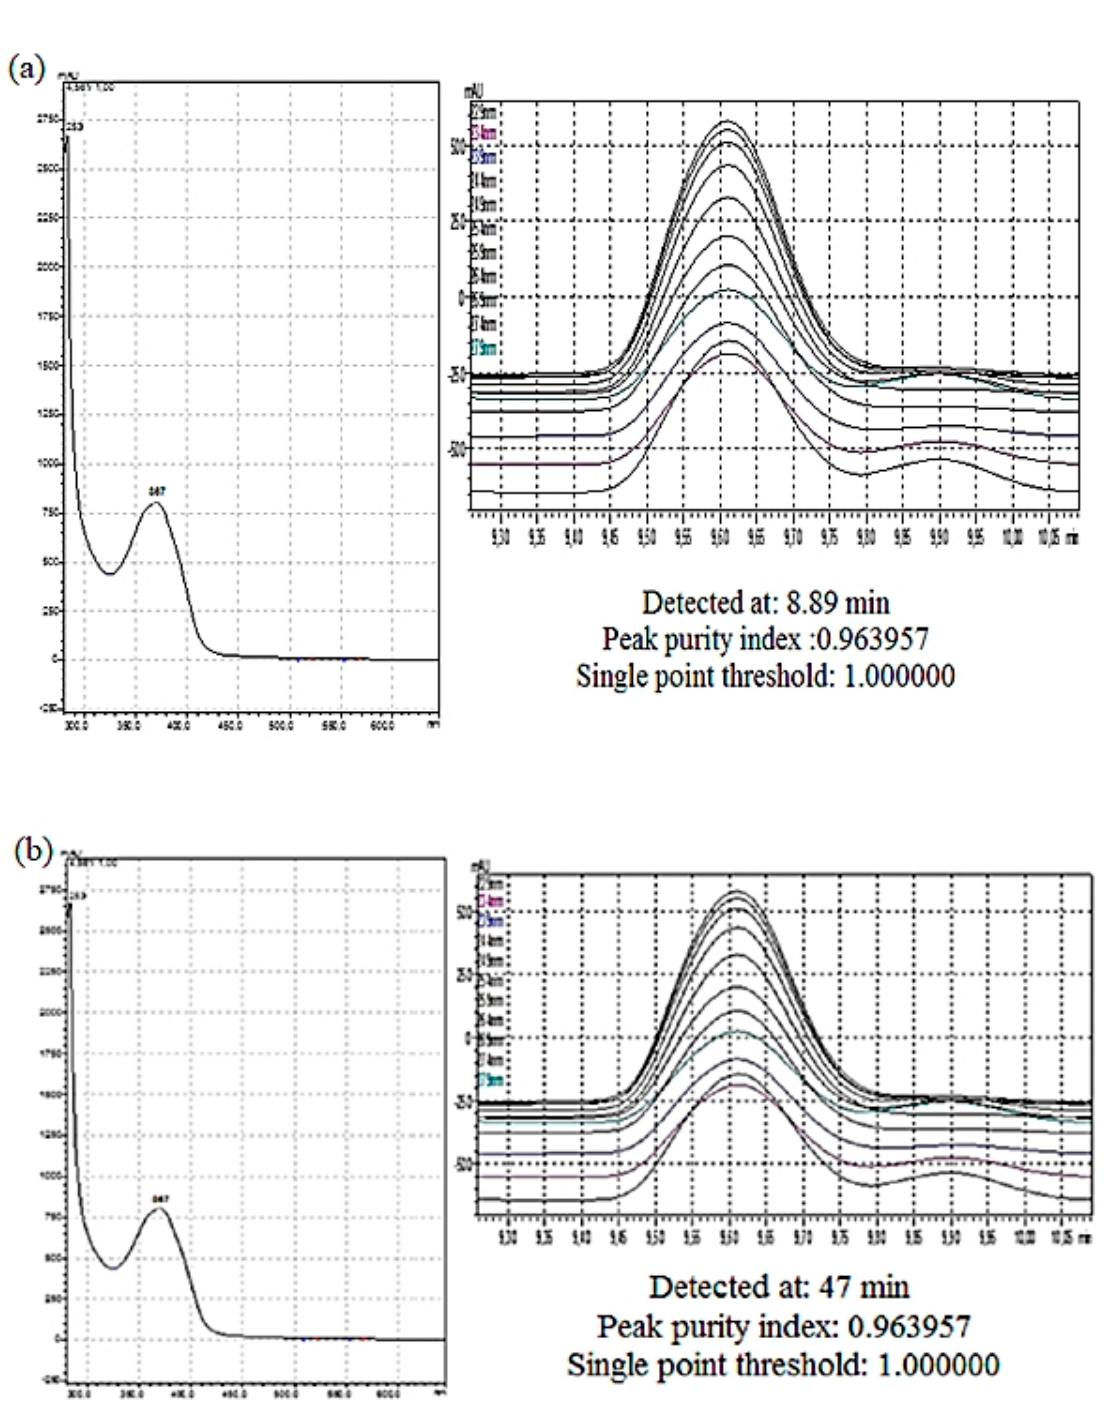
Figure 6. UV-vis apex absorption spectra of ( a ) Compound 1 (Dehydroabietic acid); and ( b ) Compound 2 (Linoleic acid).